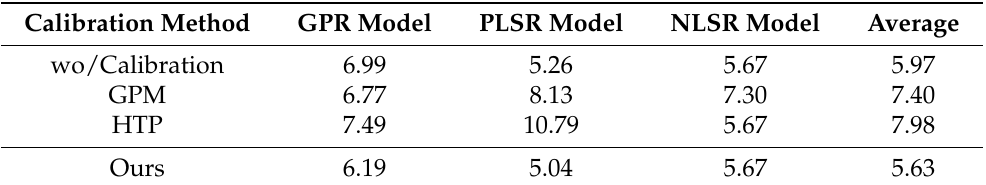
Table 3. Absolute mean error (degree) of within-subject performance on different calibration methods. GPM: Gaussian process mapping; HTP: homography transform mapping.